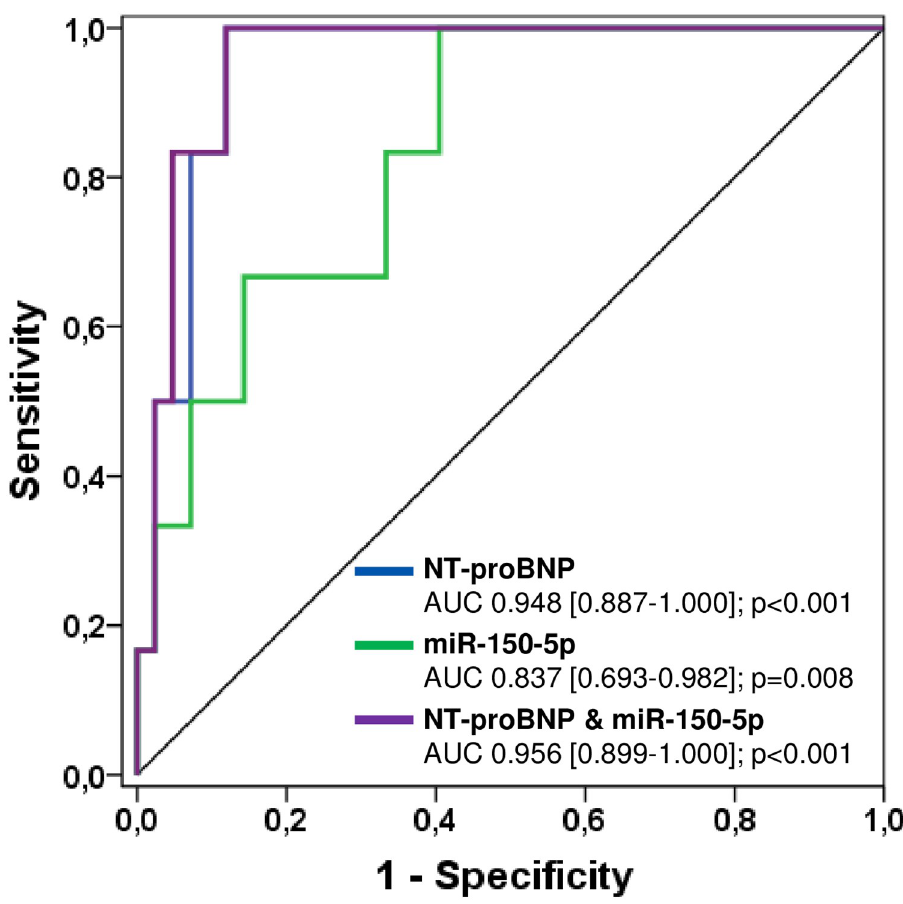
Fig 4. Receiver-operating characteristic (ROC) curves comparing sensitivity and specificity of NT-proBNP and miR-150-5p in predicting all-cause mortality. AUC, area under the curve.